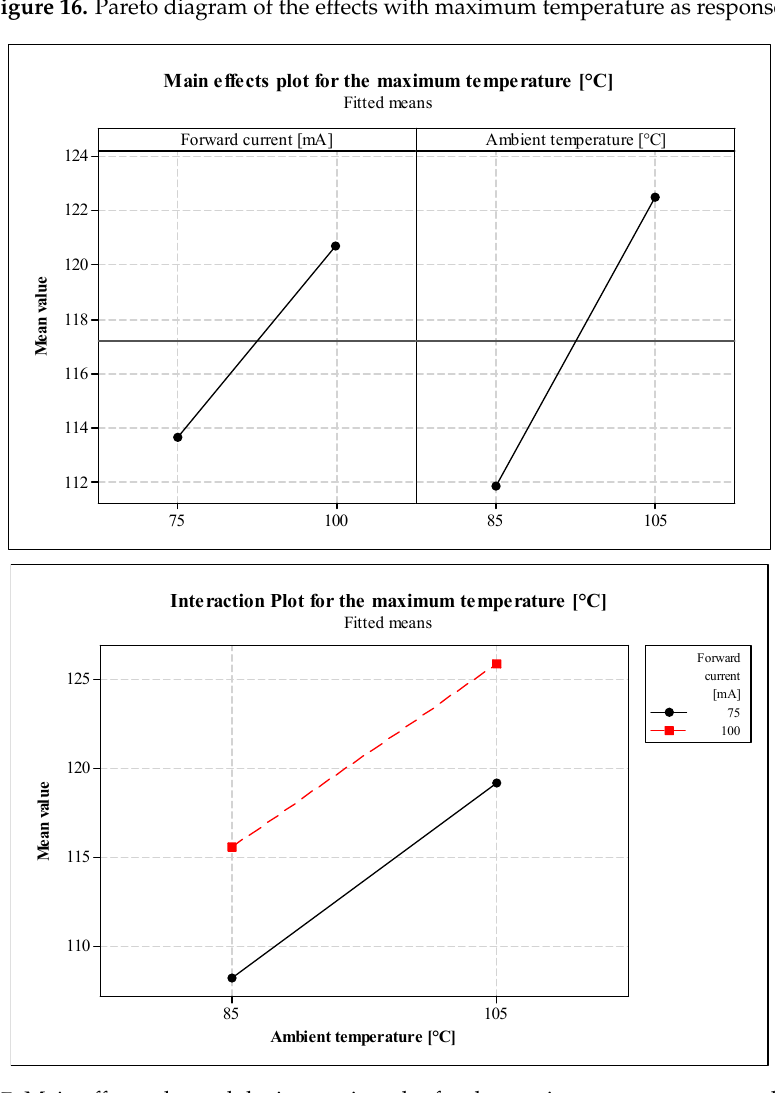
Figure 17. Main effects plot and the interaction plot for the maximum temperature at the LEDs.